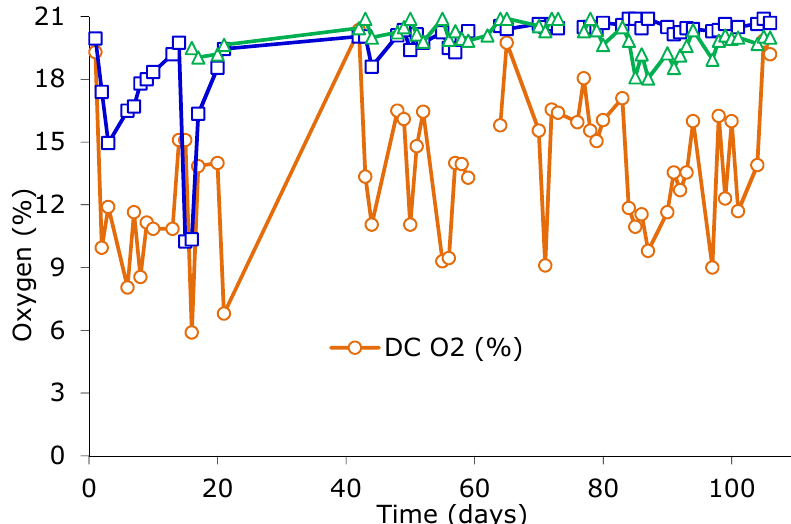
Figure 5. Oxygen concentration in dynamic (DC) and static composters (SC receiving fresh BWUC, several SMC batches receiving the material from the DC).